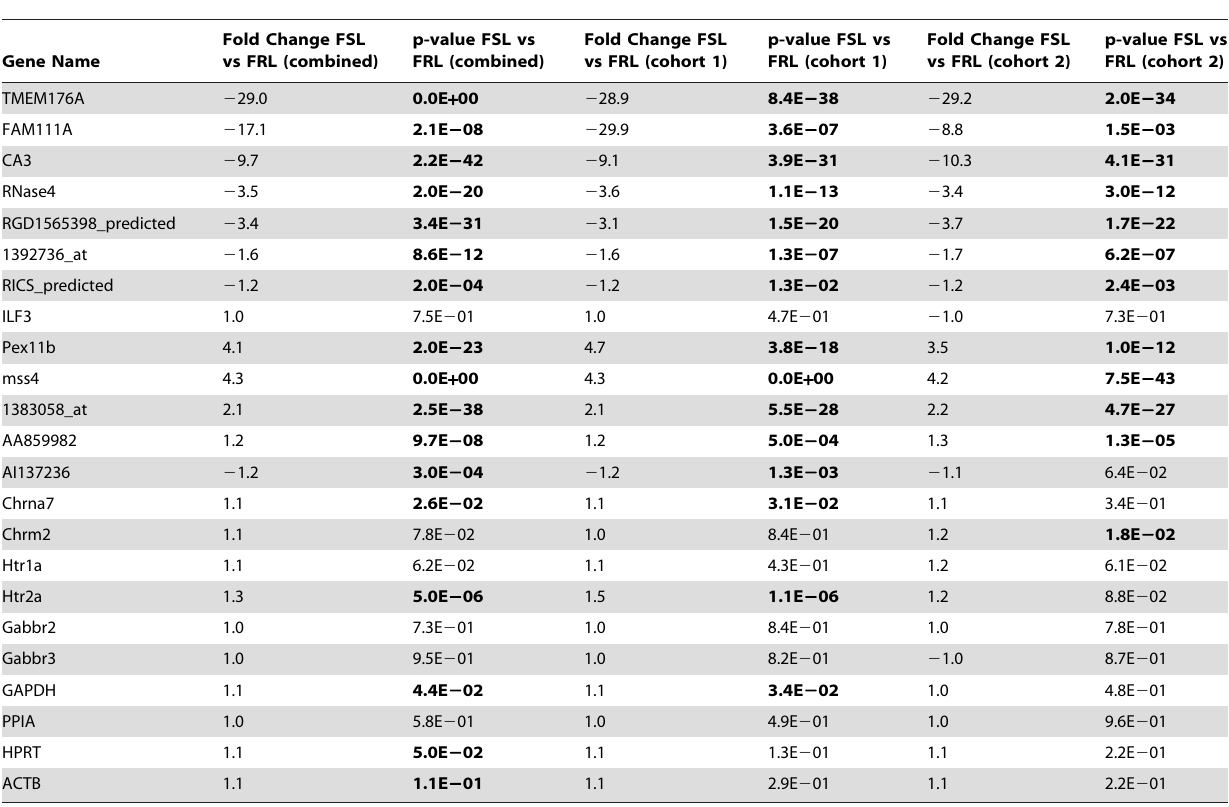
Table summarising output of mixed model analysis of variance analysis of the real-time PCR data for HIP. Column 1 shows gene name; columns 2 and 3 show fold change and p-value respectively for the combined cohort analysis; column 4 and 5 show fold change and p-value respectively for cohort 1; columns 6 and 7 show fold change and p-value respectively for cohort 2.